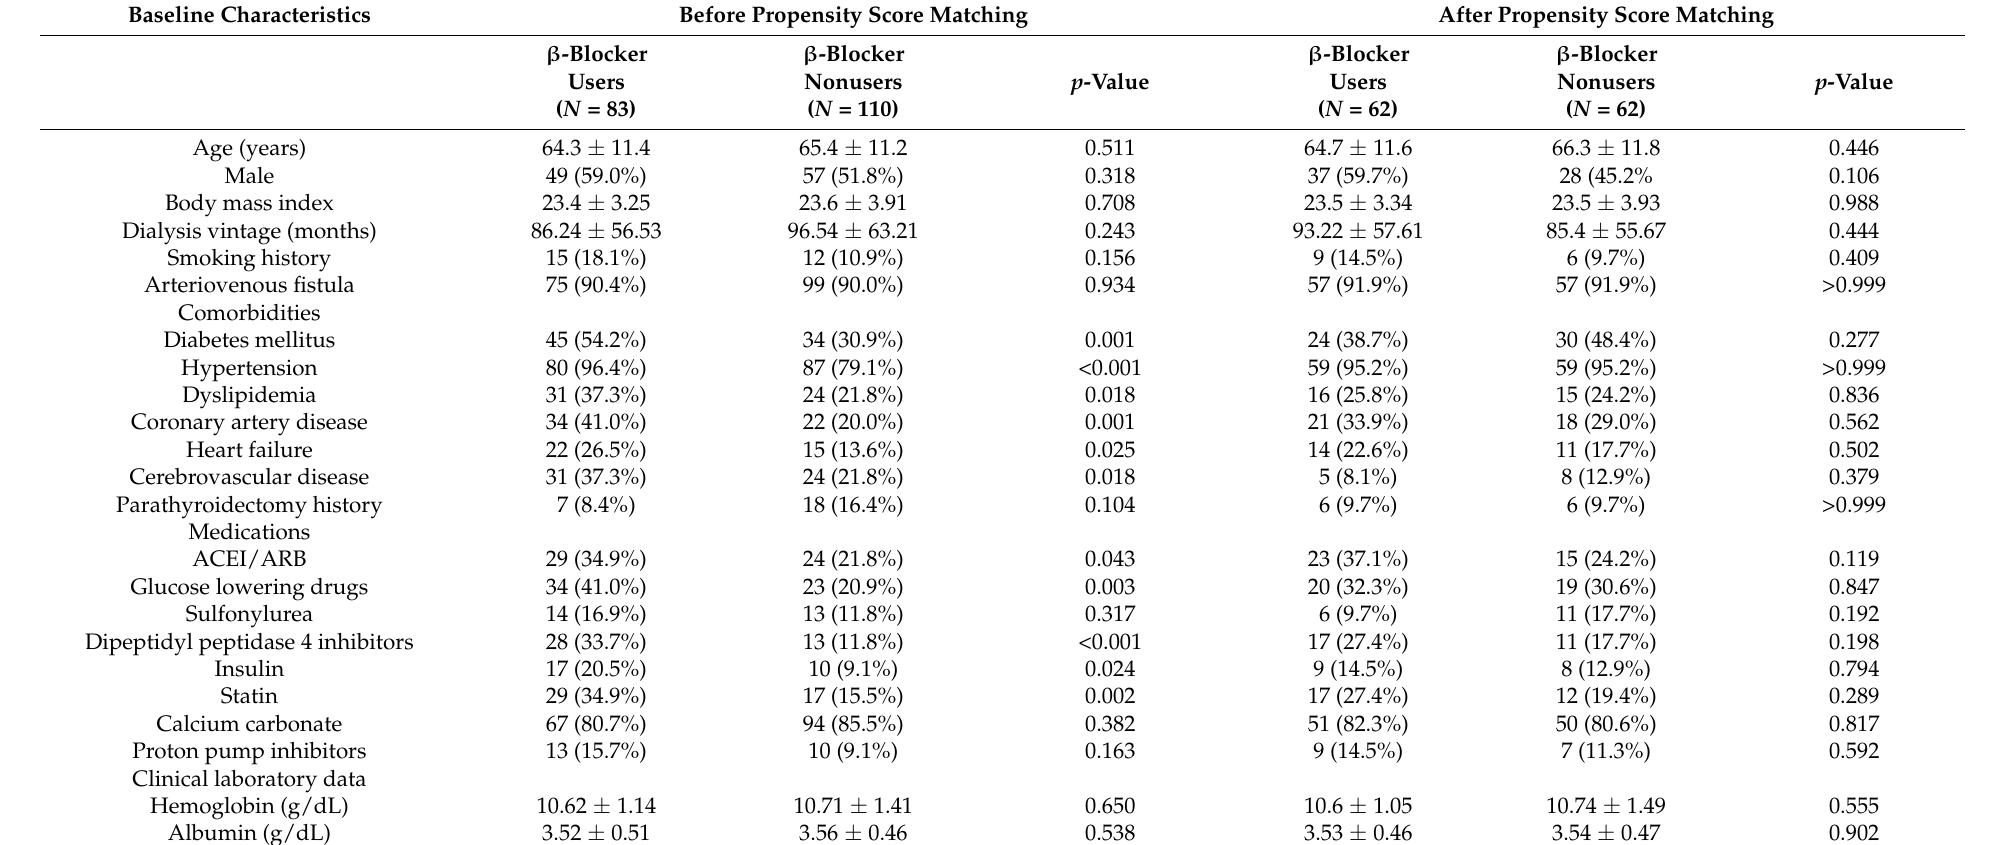
Table 1. Baseline characteristics of hemodialysis patients with and without β blocker